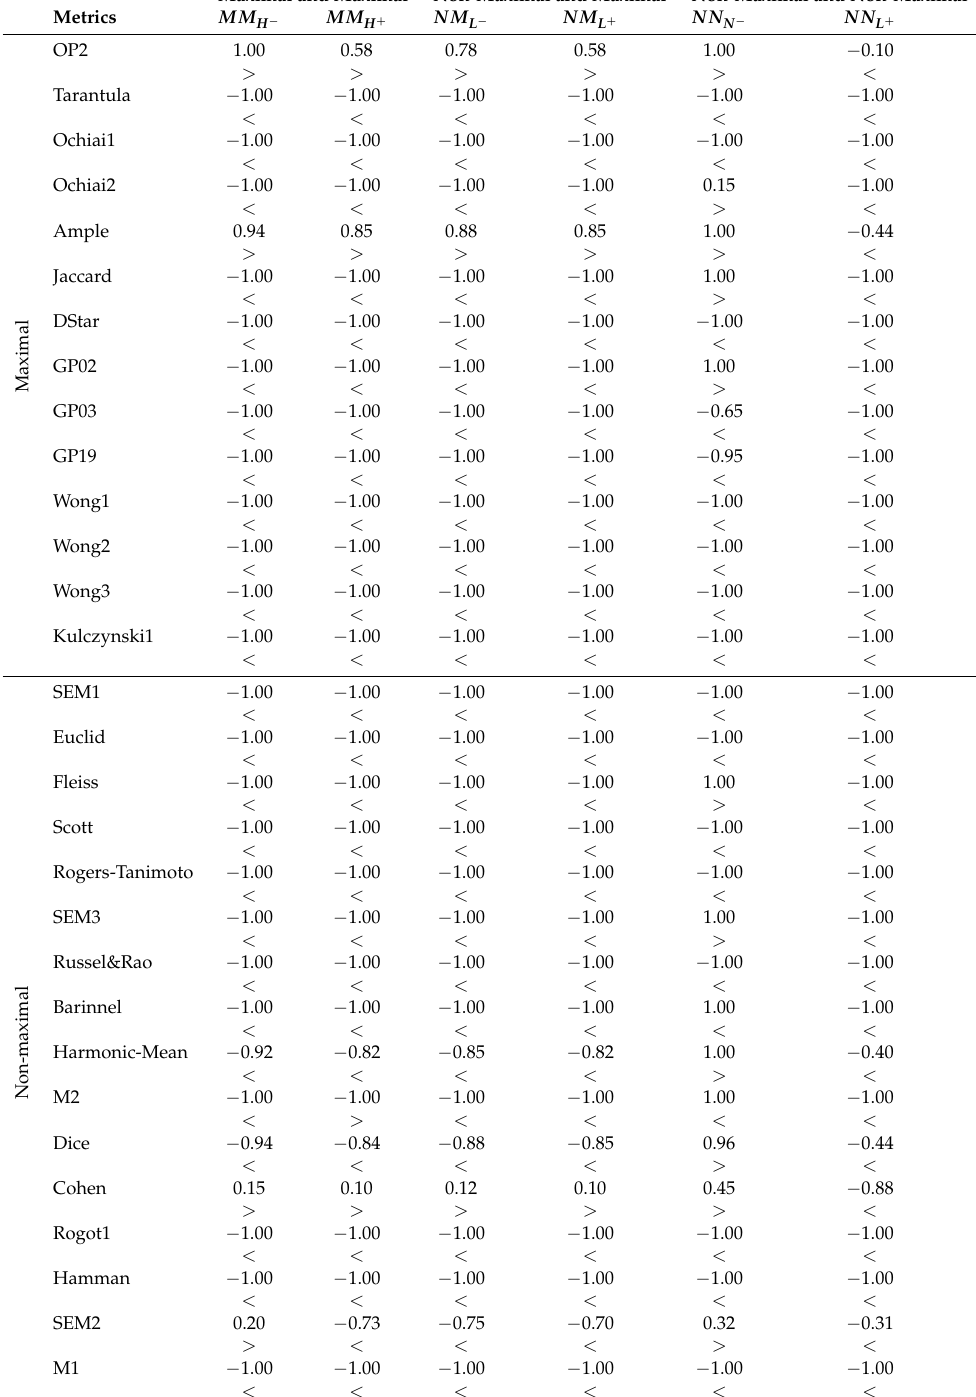
Table 8. The statistical comparison of the combined and standalone risk evaluation metrics. Maximal and Maximal Non-Maximal and Maximal Non-Maximal and Non-Maximal